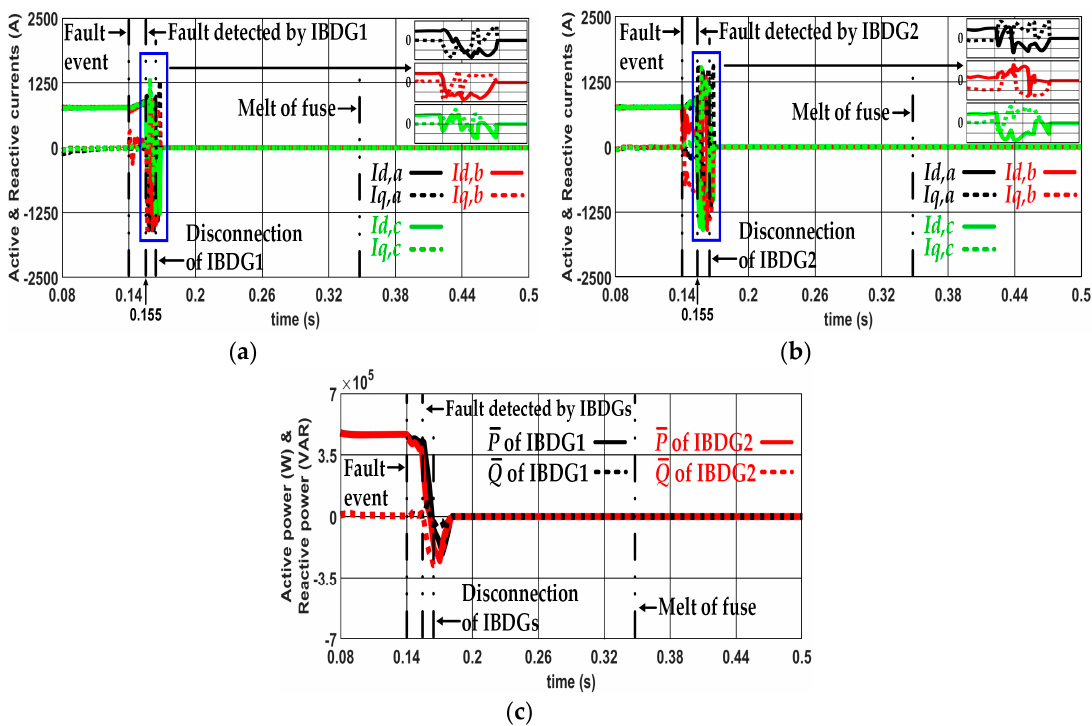
Figure 11. Conventional current control during temporary SLG fault: ( a ) active and reactive currents of IBDG1; ( b ) active and reactive currents of IBDG2; and ( c ) average powers of all IBDGs.